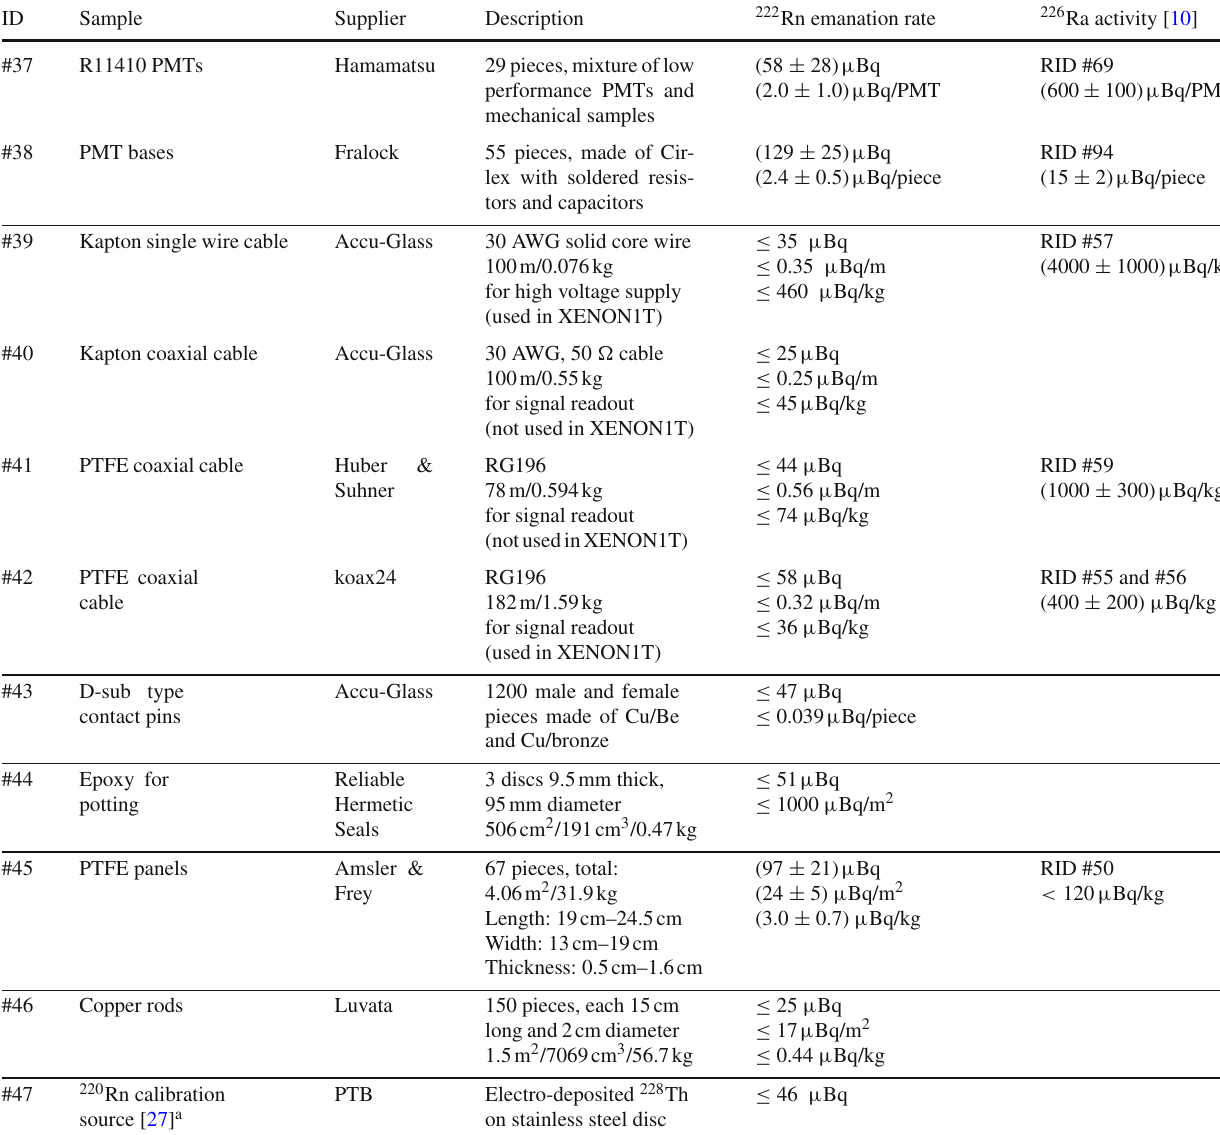
Table 7 222 Rn emanation measurements of various other samples. For comparison the 226 Ra bulk activity taken from [10] is quoted and referred to as RID (Radioassay-ID) defined